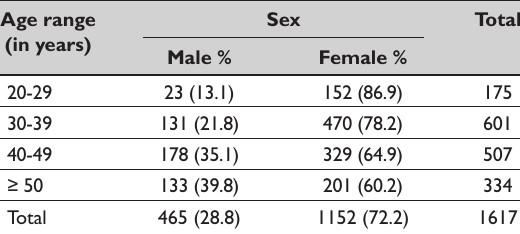
Table 1: Distribution by age and sex